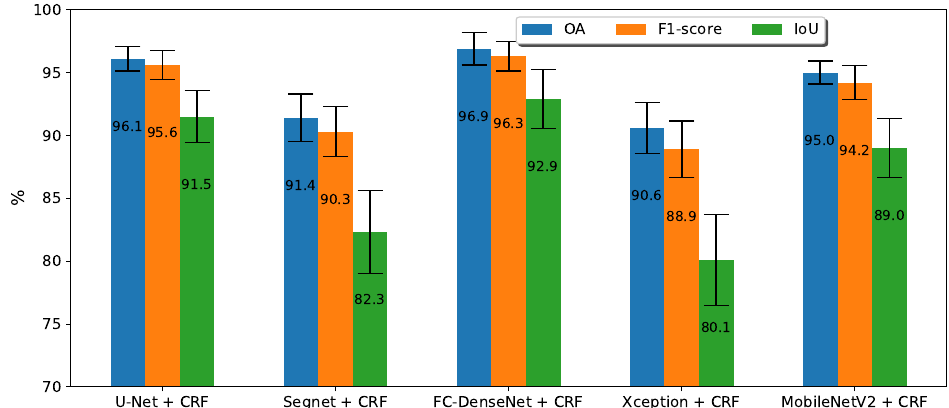
Figure 8. Average of the accuracy, F1-score, and IoU in fivefold cross-validation for all the methods using CRF.